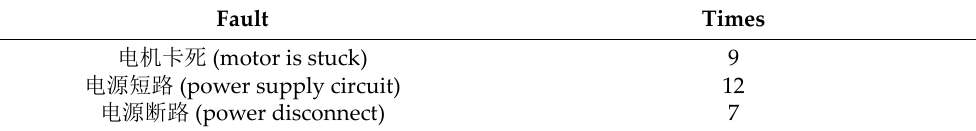
Table 8. The times of failures. Fault Times